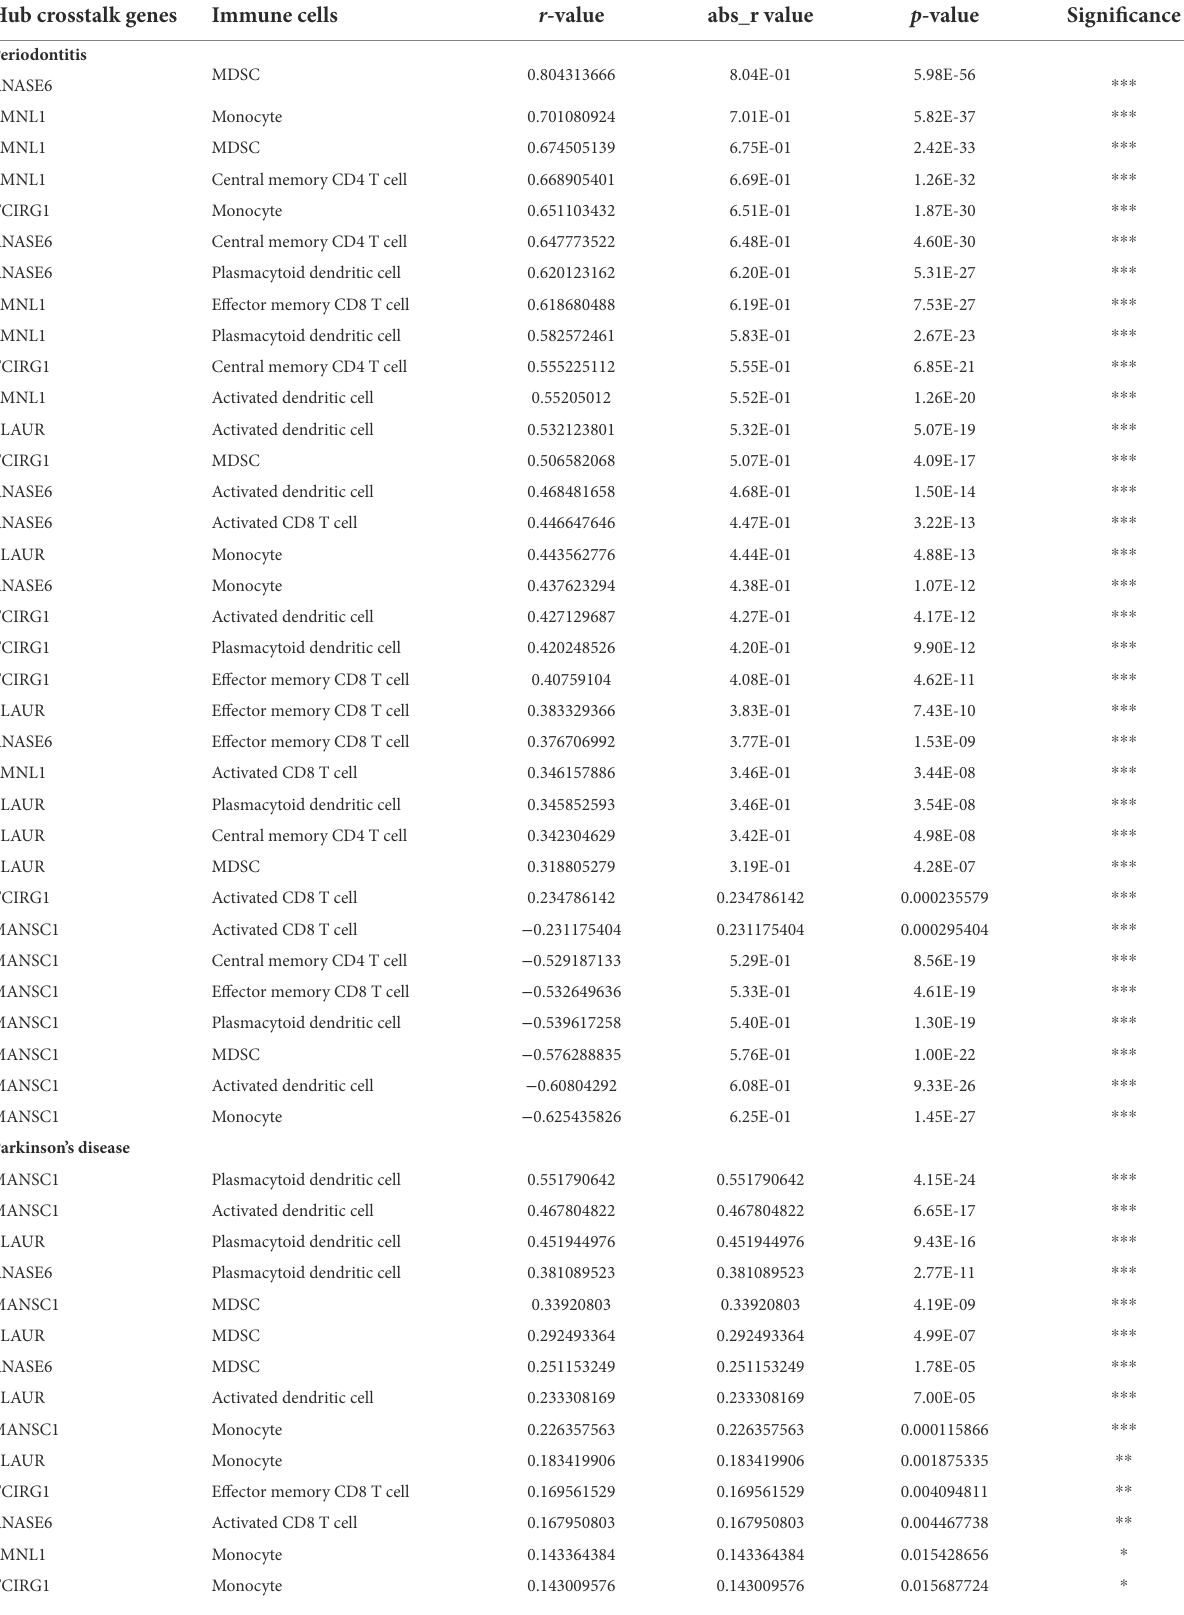
TABLE 8 The correlation between hub crosstalk genes and immune cells in periodontitis and Parkinson’s disease, respectively. Hub crosstalk genes Immune cells r